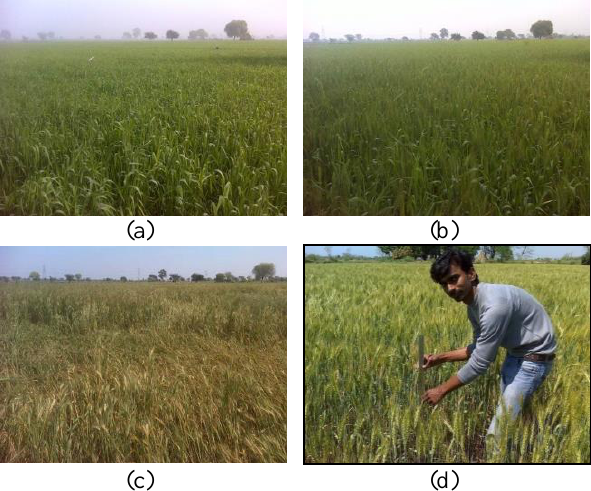
Figure 2. Ground-based photographs of a wheat field taken on (a) 25 January 2016; (b) 19 February 2016; (c) 15 March 2016 and in-situ data collection